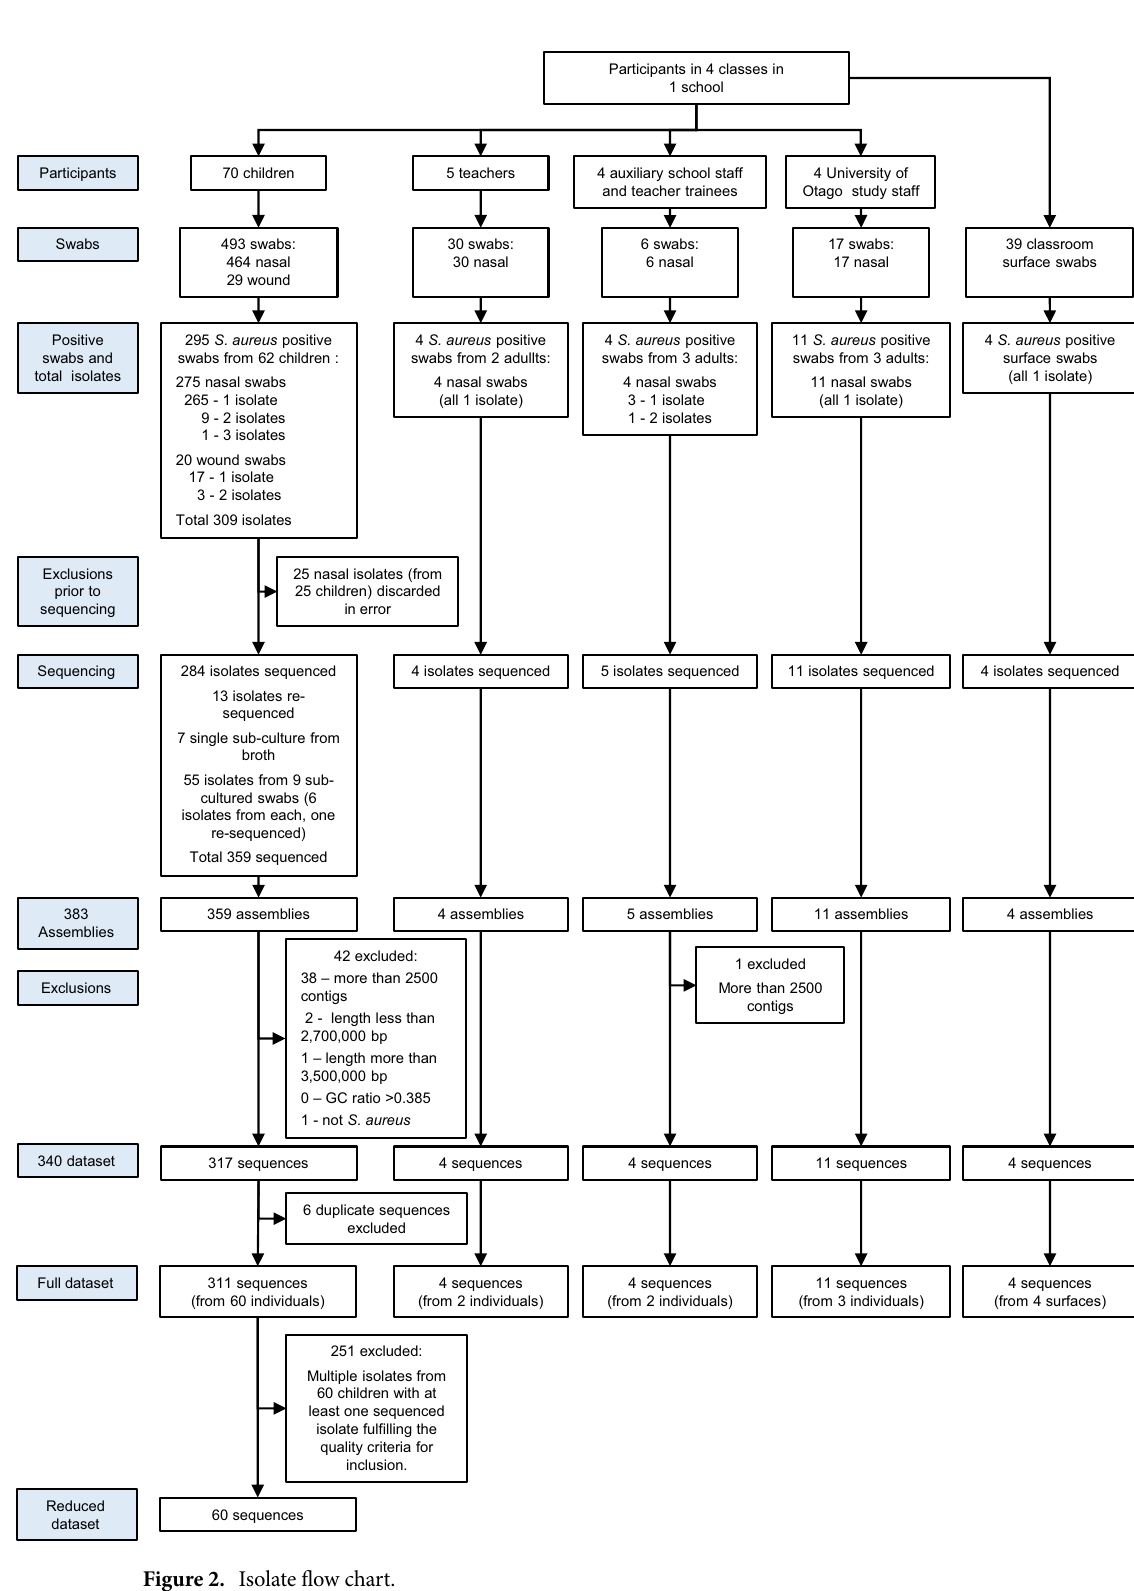
Figure 2. Isolate flow